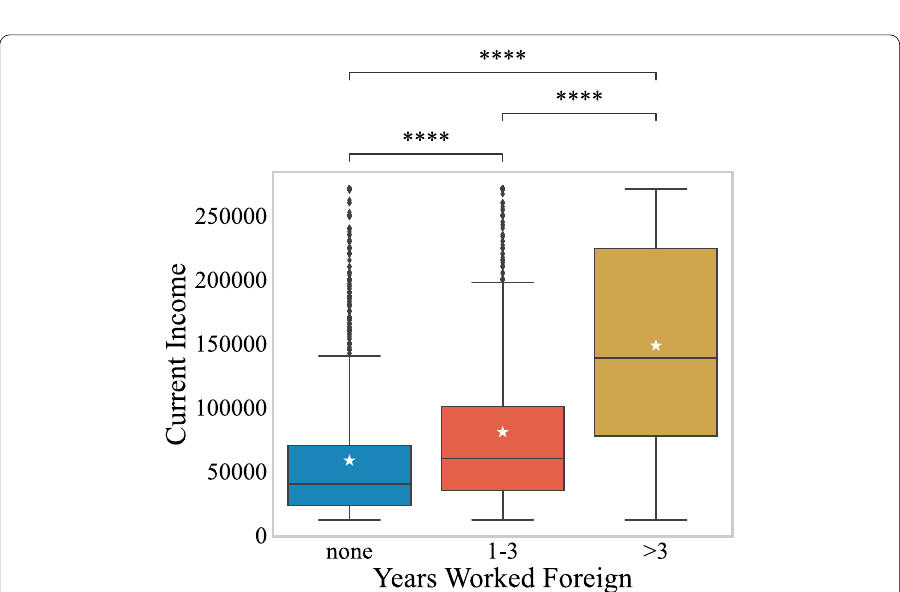
Fig. 7 First Income and Current Income boxplot based on Years Worked Foreign variable distribution